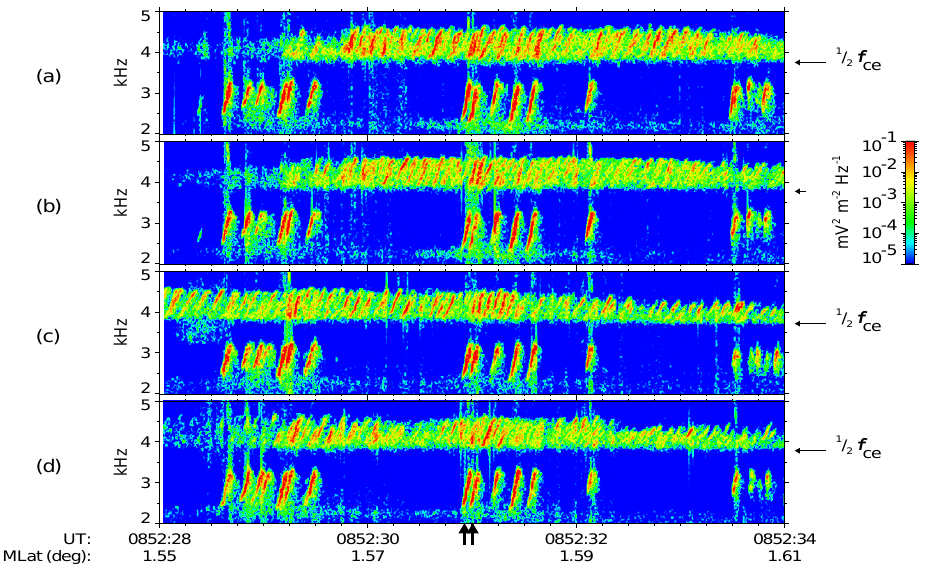
Fig. 3. Fig. 3. Spectrograms of chorus, in the same format as shown in Fig. 2, at 08:52:28UT on 18 April 2002. The two black arrows are explained